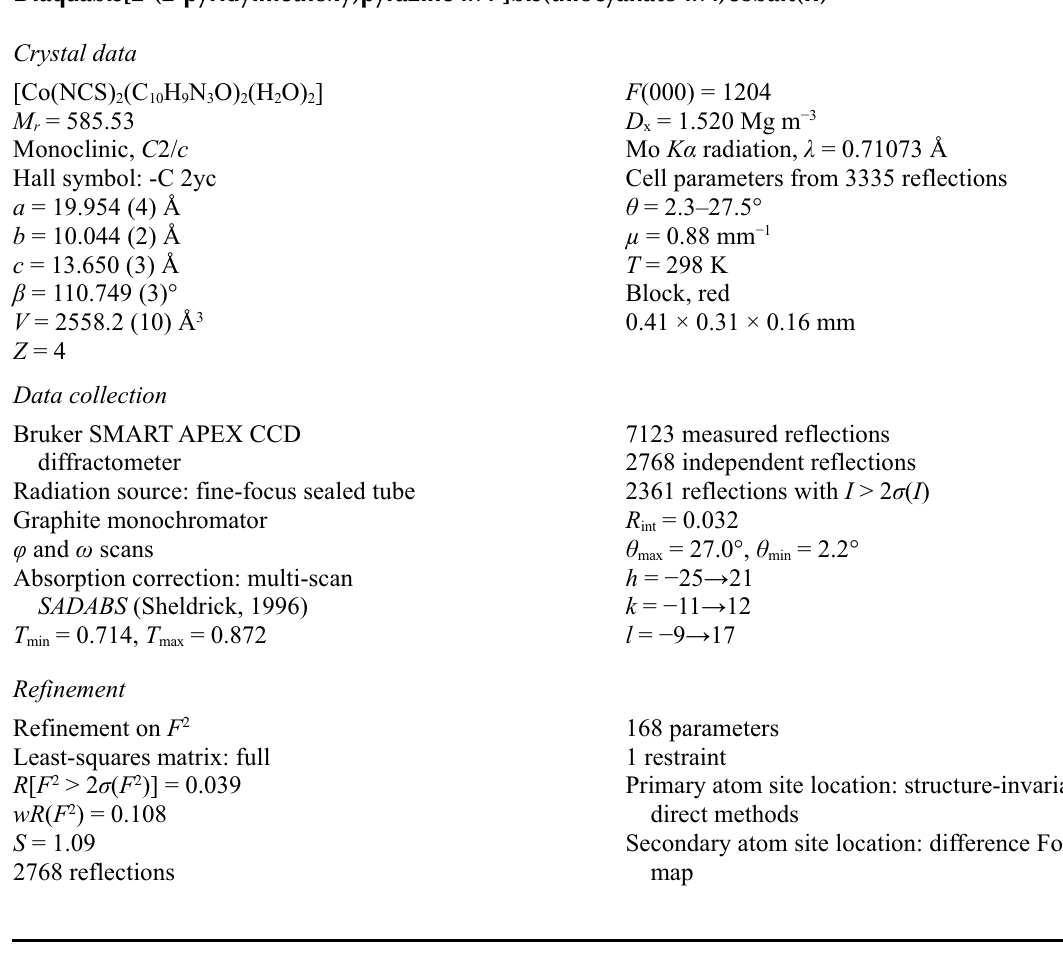
Figure 2 Part of the crystal structure of (I). Hydrogen bonds are shown as dashed lines. Diaquabis[2-(2-pyridylmethoxy)pyrazine- κ N 4 ]bis(thiocyanato- κ